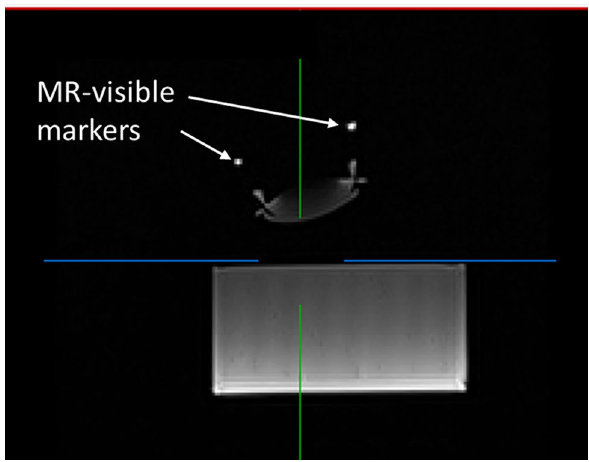
Figure 5. T1-weighted MR image used for the estimation of the transducer position and orientation in the MR